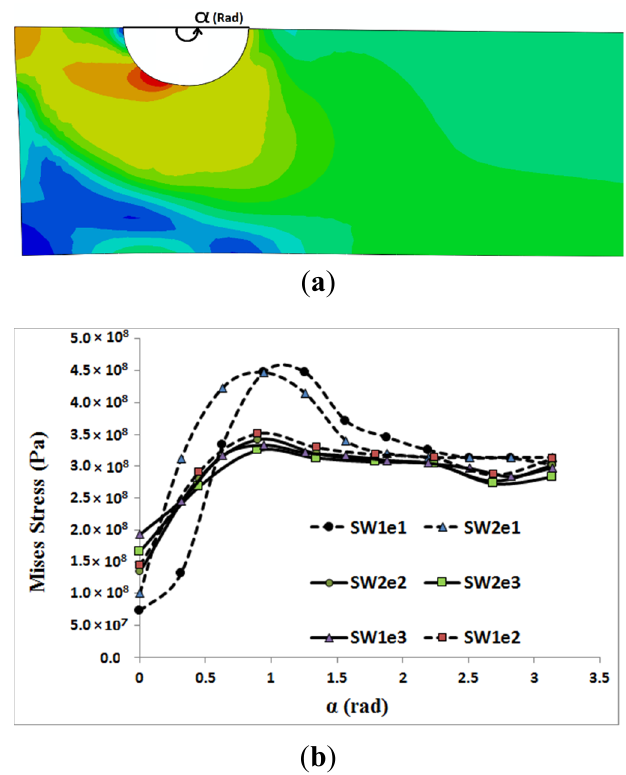
Figure 6. Von Mises stress distribution on the hole circumference versus angle α , when the tensile load in the middle plate of single bolt joints reached 10 kN: ( a ) stress contour; ( b ) stress profiles.